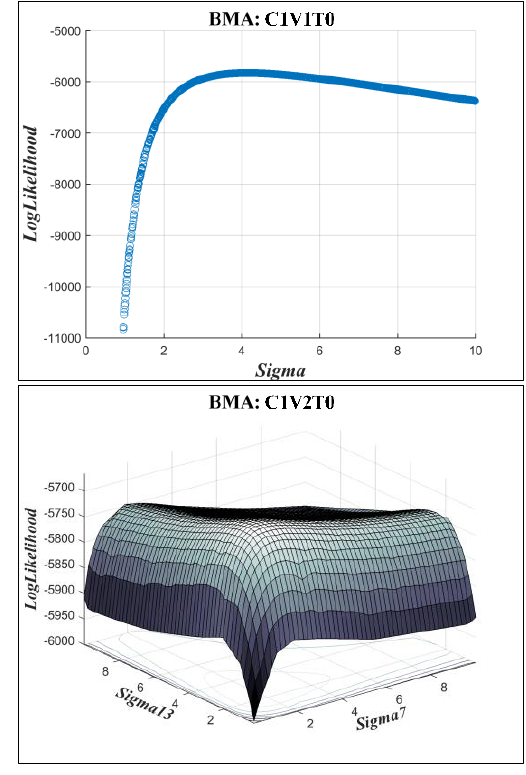
Figure 12. The RSA plots for the parameters of the C1V2T0 BMA variant for both the Big East River and Black River watersheds.